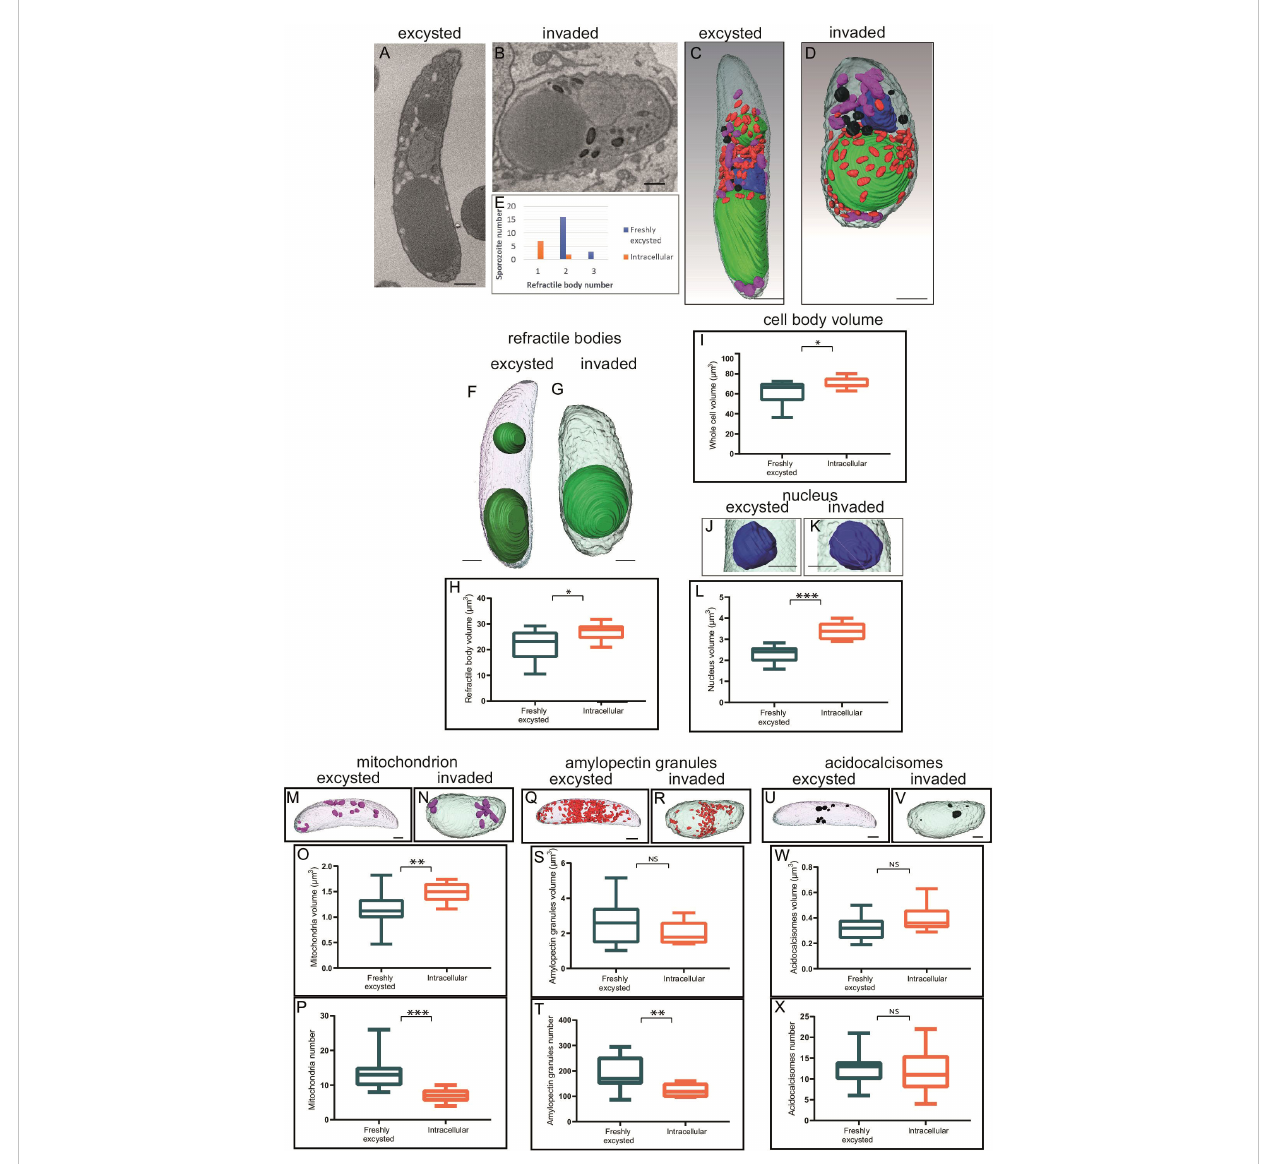
FIGURE 3 Morphometric comparison between extracellular and invaded sporozoites 2.5 hpi. (A, B) Single slice from SBF-SEM data of an extracellular sporozoite and an intracellular sporozoite at 2.5 hpi, respectively. (C, D) Three-dimensional model from SBF-SEM data of a extracellular sporozoite and an intracellular sporozoite at 2.5 hpi, respectively. Nuclei (blue), RB (green), amylopectin granules (red), mitochondria (purple) and acidocalcisomes (black); Scale bars ~ 1 m m. (E) Numbers of extracellular or intracellular (2.5 hpi) sporozoites containing either one, two or occasional three RB; (F-X) Morphometric comparison between extracellular and intracellular sporozoites for RB volume (F-H) , cell body volume per cell (I) , nucleus volume per cell (J-L) , mitochondria volume and number per cell (M-P) , amylopectin granule volume and number per cell (Q-T) , acidocalcisome volume and number per cell (U-X) . NS = not signi fi cant, *p ≤ 0.05, **p ≤ 0.01, ***p ≤ 0.001 – T test or Mann Whitney U for volume measurements. Scale bars = 1µm; NS, not statistically signi fi